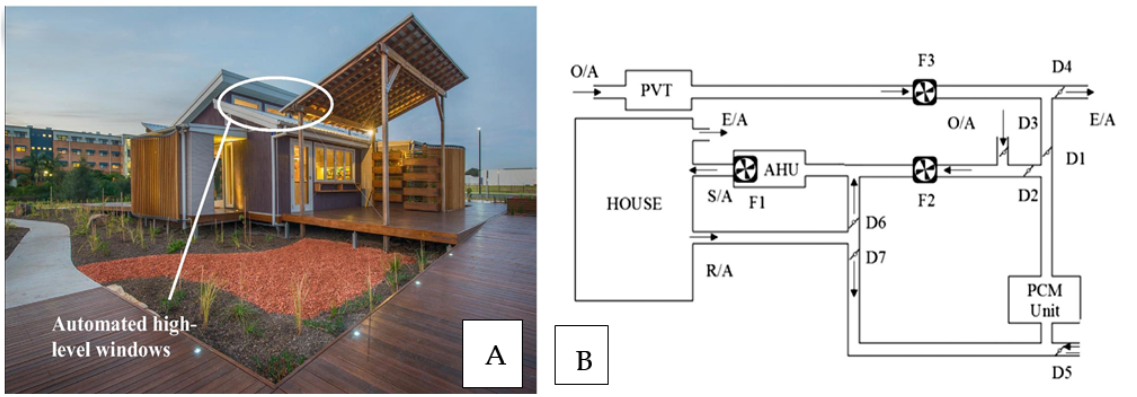
Figure 14. ( A ) The “Team UOW Solar Decathlon House”, ( B ) the overall view of HVAC system [143].